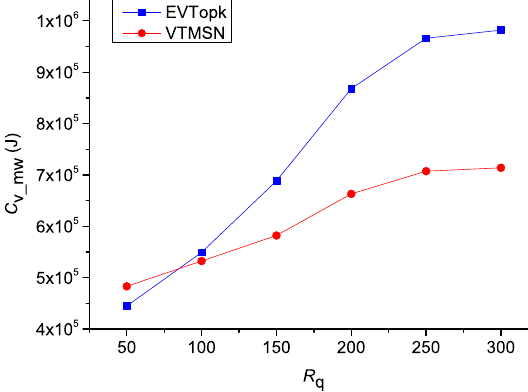
Figure 7. C mw with different settings of R q .